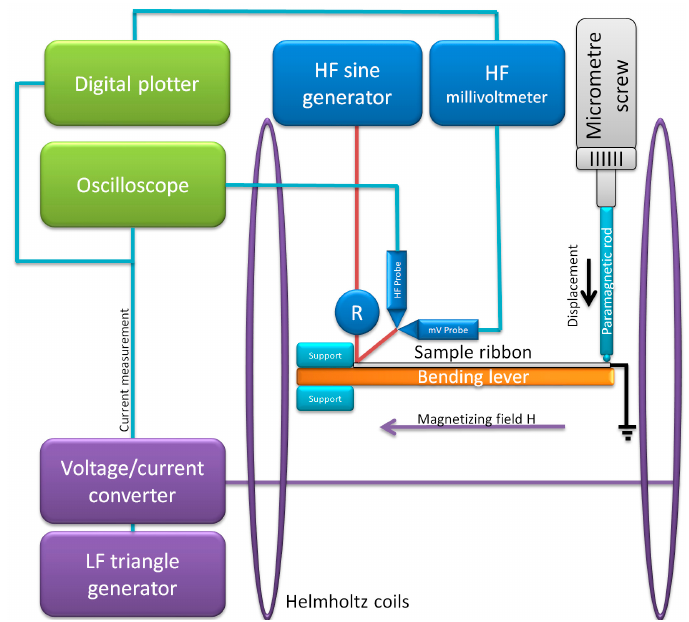
Figure 1. Schematic diagram of the developed Giant Magnetoimpedance (GMI) measurement system. Legend: HF, high frequency; LF, low frequency.